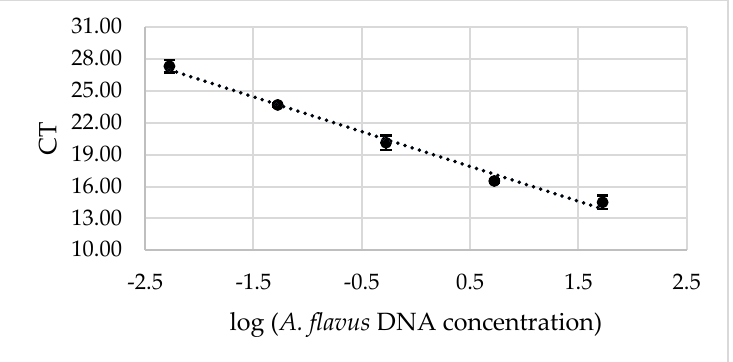
Figure 1. Standard curve for the real time PCR assay of A. flavus DNA. Bars represent confidence intervals (α = 0.05).